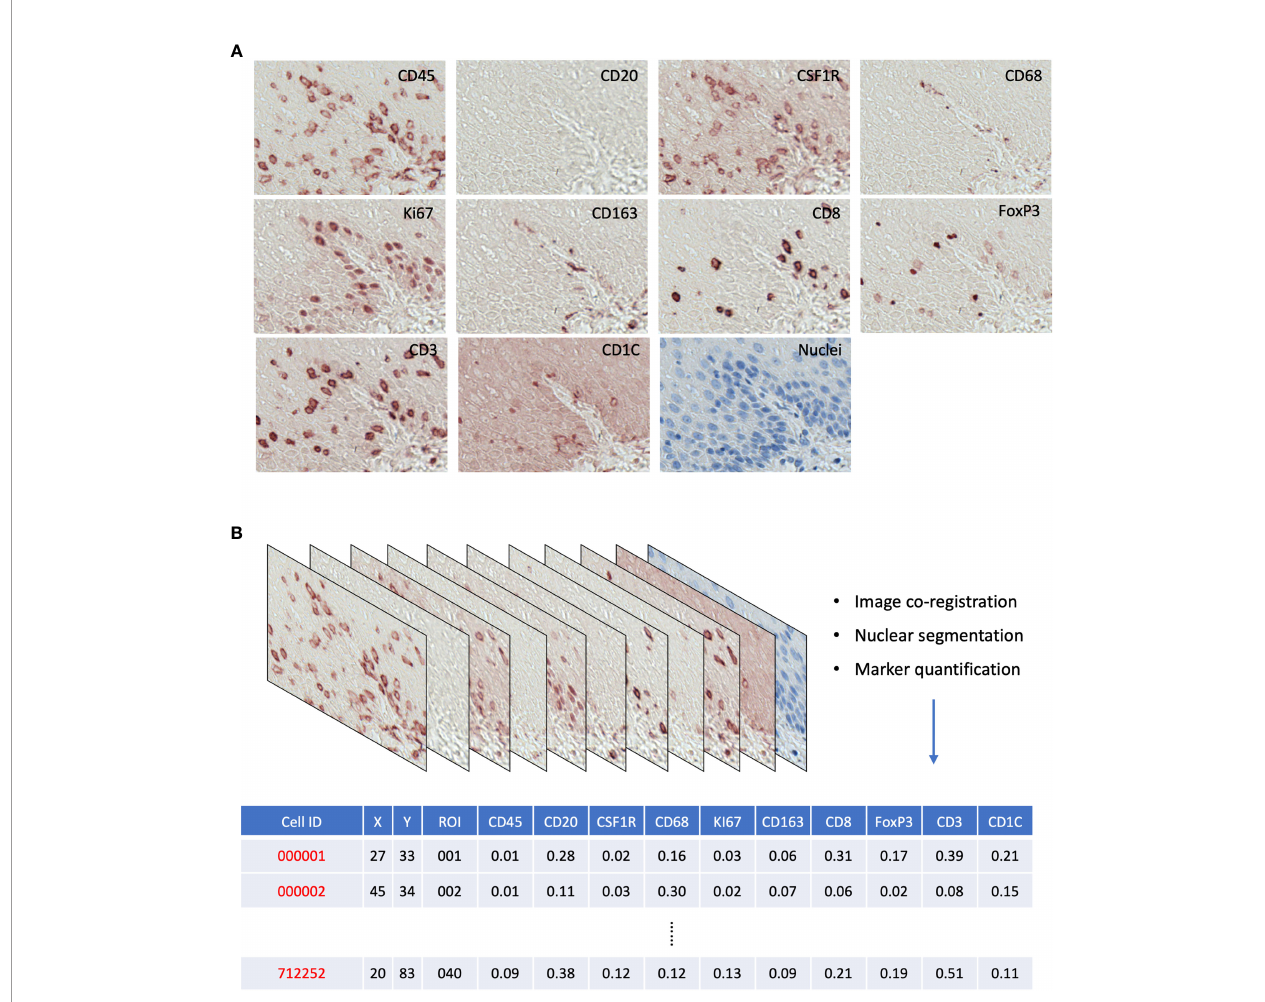
FIGURE 2 | (A) Raw AEC staining for each marker and hematoxylin staining for nuclei. (B) Schematics of raw image processing and raw data format, each row is a cell with its ID and ROI; x , y coordinates; and quantitative expression values for each mIHC